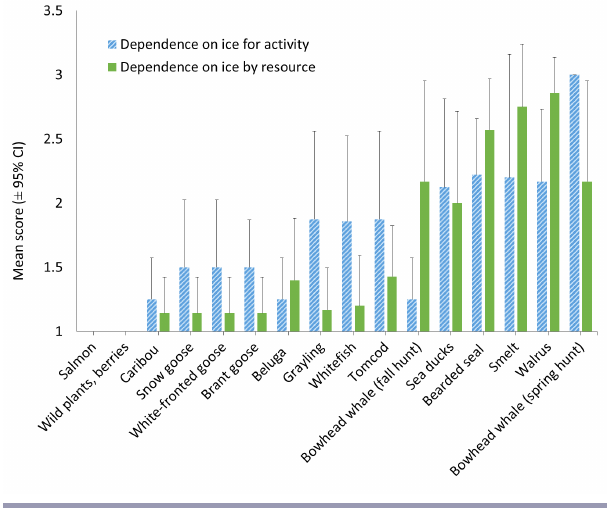
Fig. 5 . Relative dependence on sea ice of subsistence resources and activities near Wainwright, Alaska. Resources were assessed on a scale of 1 (low dependence) to 3 (high dependence). Error bars denote 95% confidence intervals. Data were collected during workshop 4 by 9 participants.